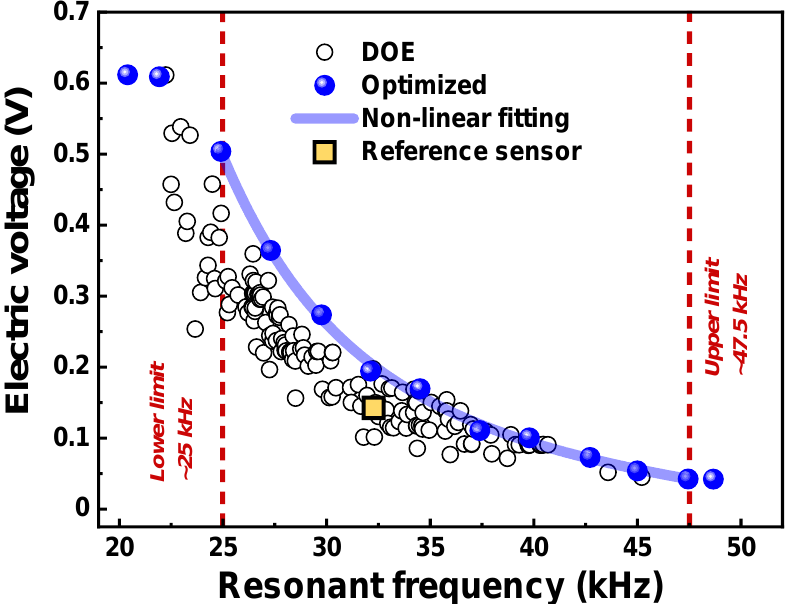
Figure 3. Plot for electric voltage vs. resonant frequency obtained through optimization process at different resonant frequencies (20–50 kHz).